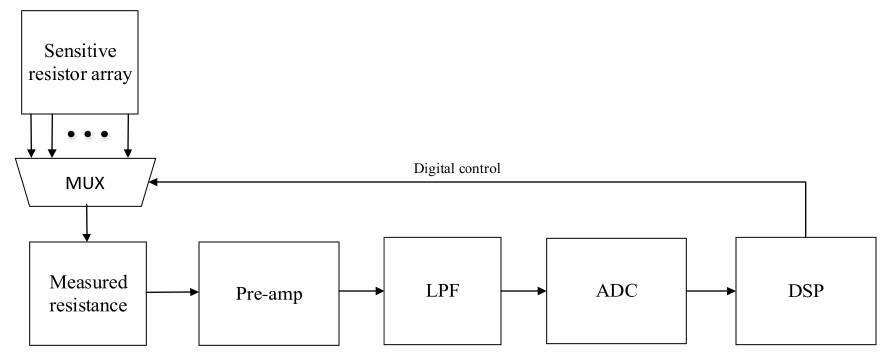
Figure 1. Schematic diagram of the basic structure of the interface